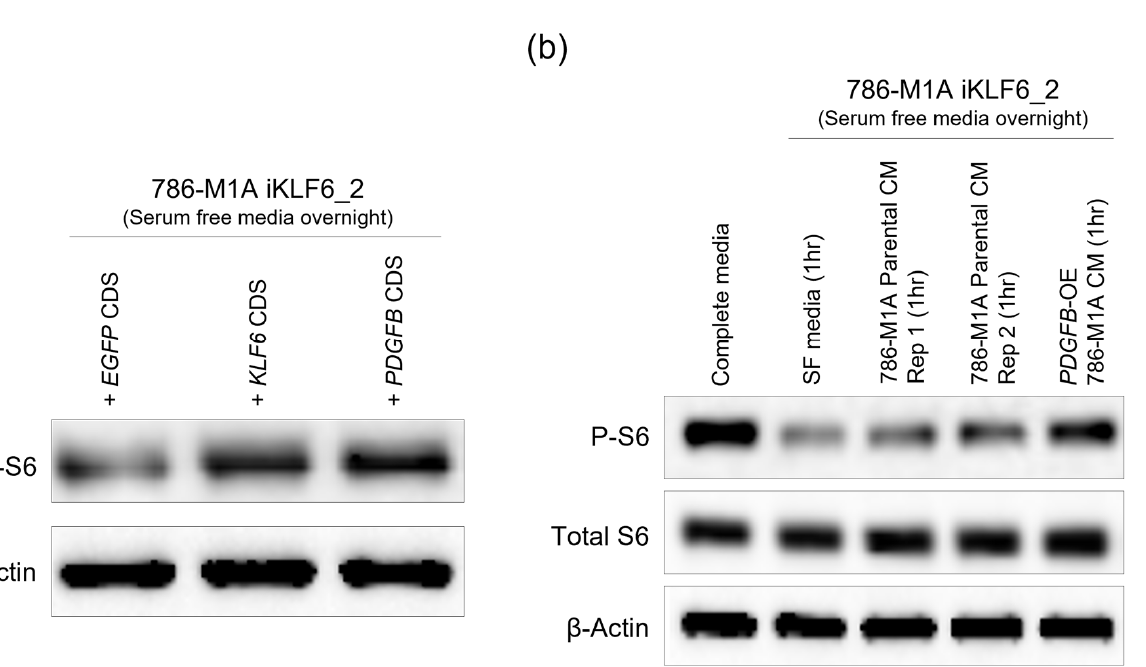
Figure 5. Secreted PDGFB stimulates mTORC1 signalling pathway activation. ( a ) Phosphorylated S6 Western blot of 786-M1A iKLF6_2 that were reintroduced with eGFP CDS, KLF6 CDS or PDGFB CDS. Representative of two experiments. ( b ) mTORC1 activity of the 786-M1A iKLF6_2 cells that were cultured with serum free media (SF), conditioned media (CM) of 786-M1A parental or PDGFB- overexpressing 786-M1A cells for 1 h following overnight serum starvation. Representative of two experiments.